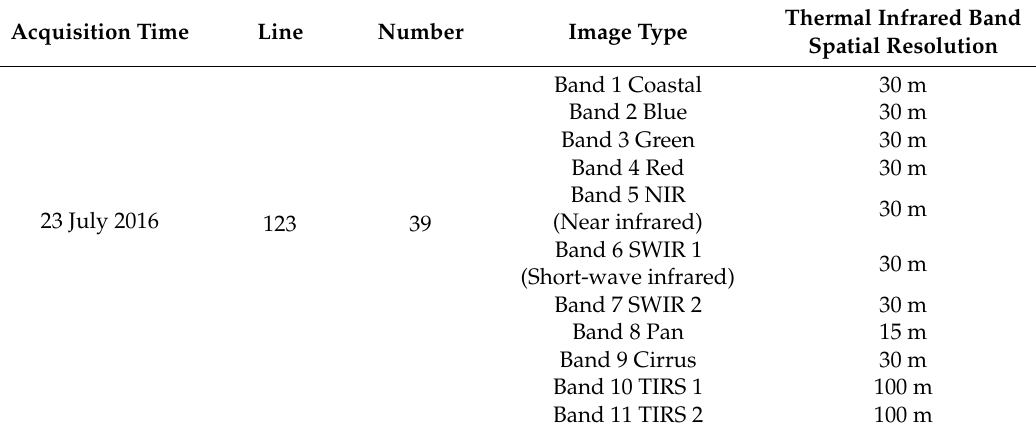
Table 1. Acquisition information of remote sensing image